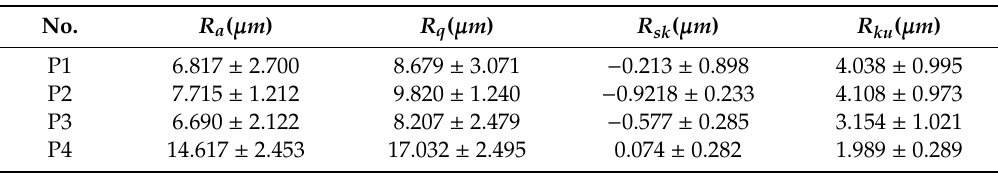
Table 3. Roughness of PTFE microporous layers.